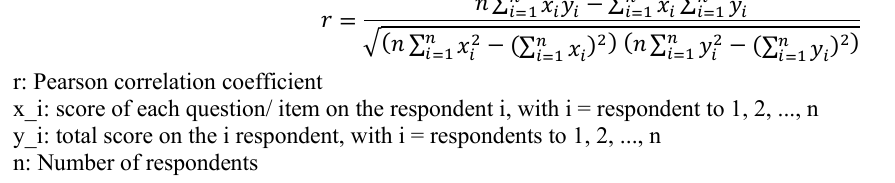
Source: Rahadi et al.